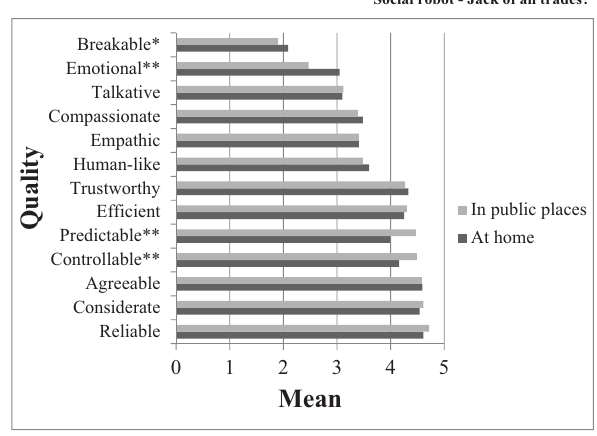
Figure 4: Robots ’ qualities desired at home and in public places, measured on a scale from 1 ( Not at all ) to 5 ( To a great extent )